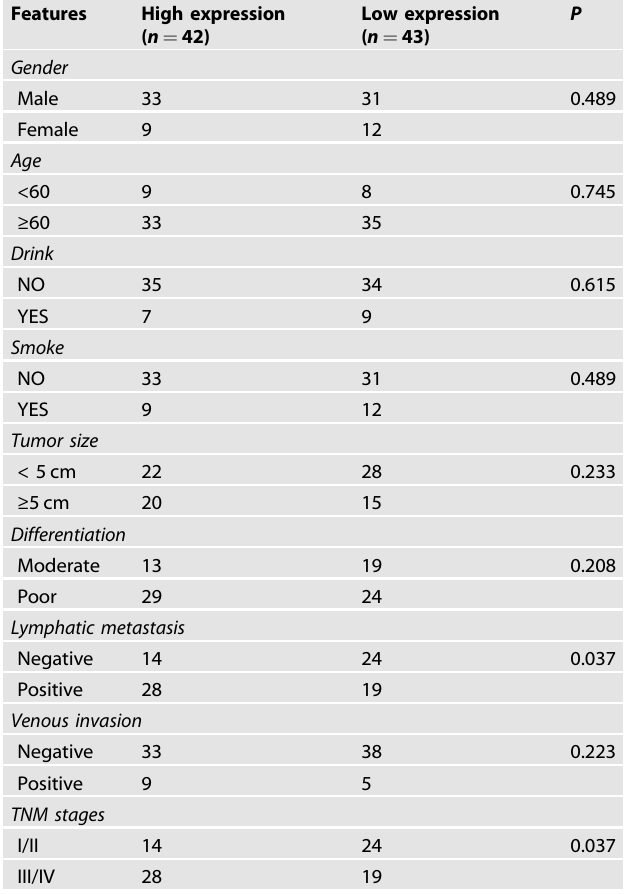
Table 1. The correlation between DLGAP1-AS2 expression and the clinicopathological characteristics of